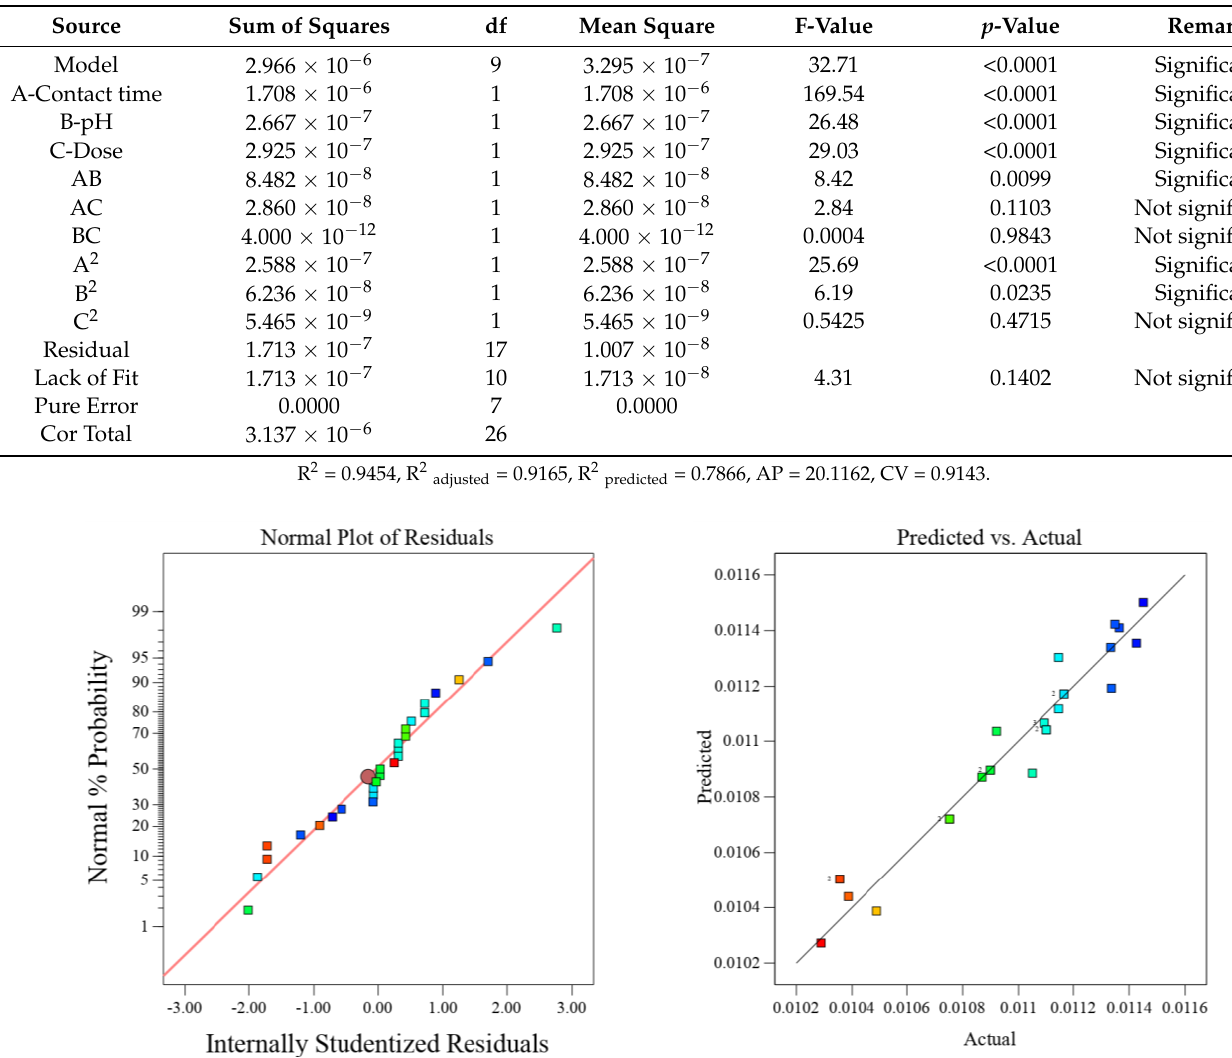
Figure 5. Two-dimensional contour and three-dimensional surface plots on the relation between contributed factors (con- tact time and pH) and Pb 2+ removal by Odaracha adsorbent. Figure 6. Two-dimensional contour and three-dimensional surface plots on the relation between contributed factors (con- tact time and dose) and Pb 2+ removal by Odaracha adsorbent.